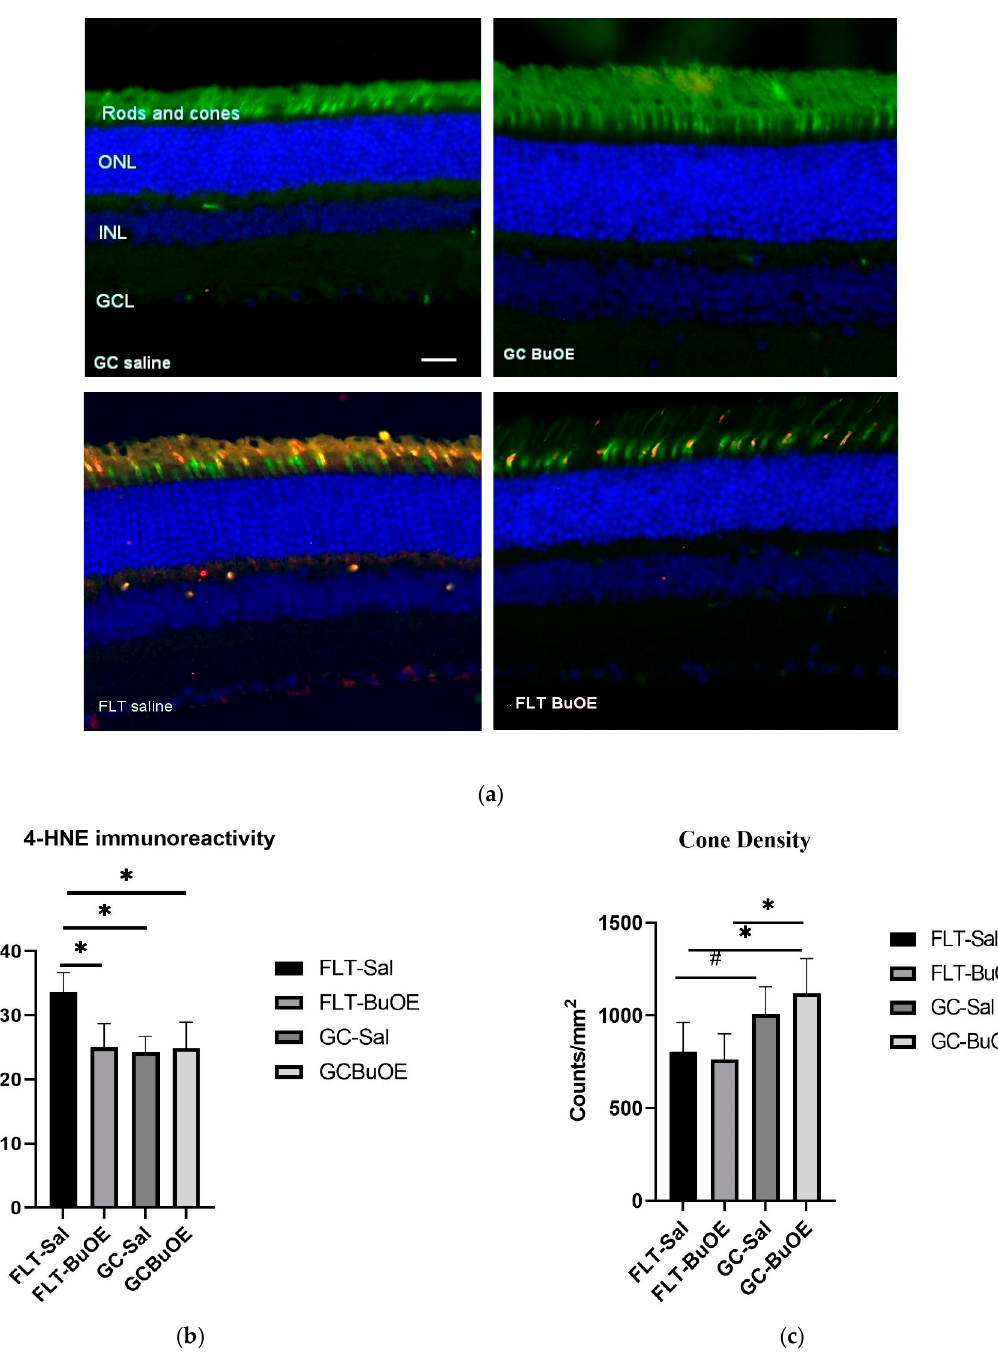
Figure 10. Oxidative damage in the retinal nuclear layer and photoreceptor layer. ( a ) Representative micro-graphs of ocular sections were evaluated in the flight (FLT) and ground control (GC) groups. Immunofluorescence staining for peanut agglutinin (PNA), a marker for cone photoreceptors (green), and 4-hydroxynonenal (4-HNE), a marker for oxidative stress (red), and the nuclei were counterstained with DAPI (blue). Scale bar = 50 µm. ( b ) The average fluorescence intensity of 4-HNE immunoreactivity. Measurements across five retinal sections per eye were used as a single experi- mental value. Values are represented as the mean density ± SEM (n = 5). * Significance higher in fluorescence intensity of the FLT-saline group compared to all other groups ( p < 0.05). ( c ) Cell density for PNA-positive cone photoreceptors. * Significance different between FLT-BuOE vs. GC-BuOE or FLT-saline vs. GC-BuOE ( p < 0.05). # Strong trend difference between FLT-saline and GC-saline ( p =